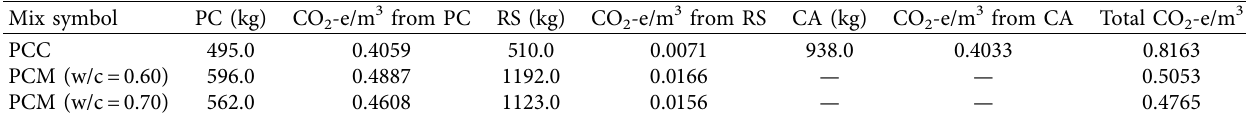
Table 5: LCA analysis of PCC and